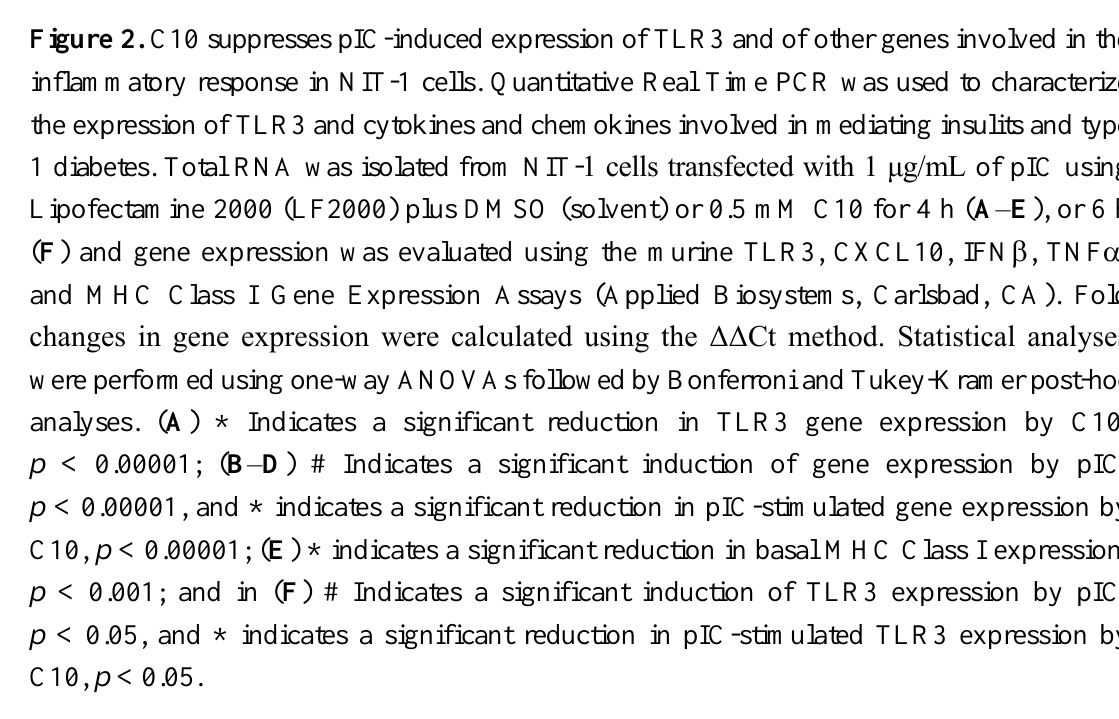
Figure 2. C10 suppresses pIC-induced expression of TLR3 and of other genes involved in the inflammatory response in NIT-1 cells. Quantitative Real Time PCR was used to characterize the expression of TLR3 and cytokines and chemokines involved in mediating insulits and type 1 diabetes. Total RNA was isolated from NIT-1 cells transfected with 1 μg/mL of pIC using Lipofectamine 2000 (LF2000) plus DMSO (solvent) or 0.5 mM C10 for 4 h ( A – E ), or 6 h ( F ) and gene expression was evaluated using the murine TLR3, CXCL10, IFN  , TNF  , and MHC Class I Gene Expression Assays (Applied Biosystems, Carlsbad, CA). Fold changes in gene expression were calculated using the ΔΔCt method. Statistical